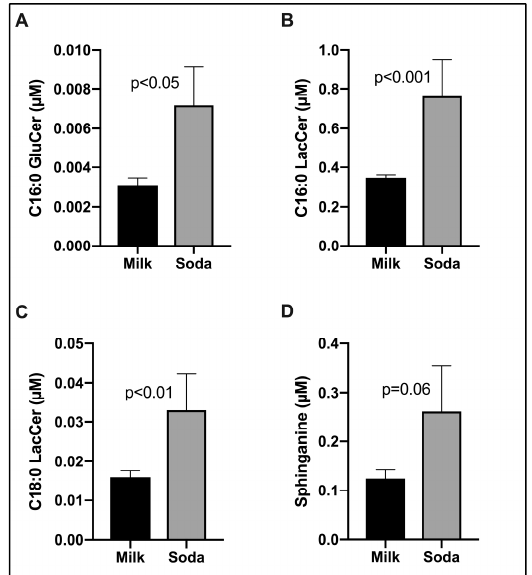
Figure 2. Replacement of SSB intake with milk significantly decreased glycosphingolipids in 30 healthy overweight/obese adolescent boys. Figures show mean ± SEM of plasma glucosylceramide (GluCer, Panel A ), lactosylceramide (LacCer, Panel B , C ) and sphinganine (Panel D ). p values were calculated based on Wilcoxon signed rank test.